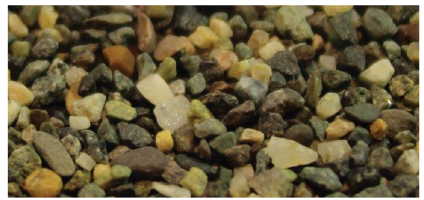
Figure 1: Example of flat angular sand particles.